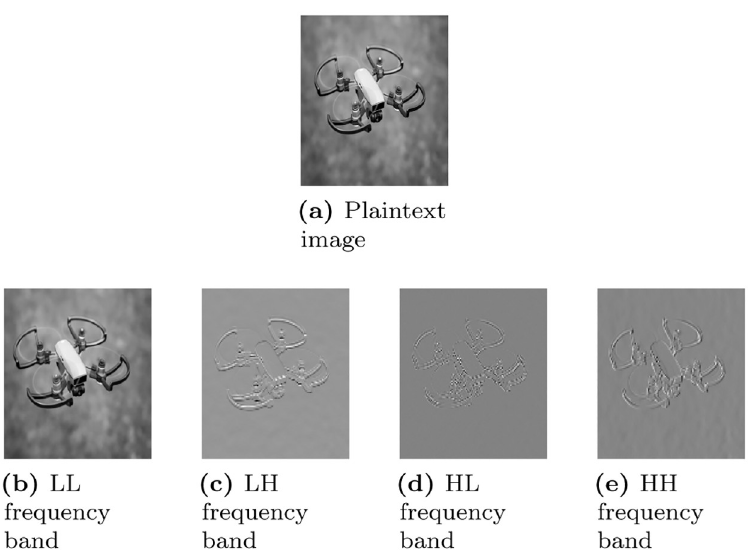
Fig 3. Frequency bands extracted from the drone image using DWT. (a) Plaintext image, (b) LL frequency band, (c) LH frequency band, (d) HL frequency band, and (e) HH frequency band.